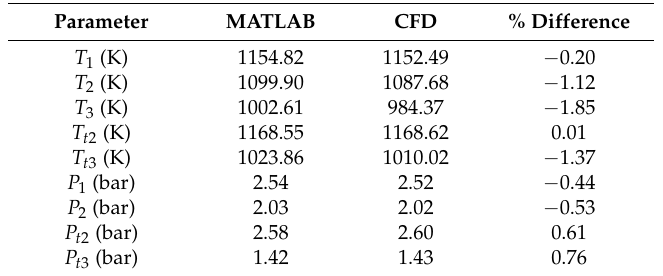
Table 7. Difference between MATLAB predicted thermodynamics and CFD results.